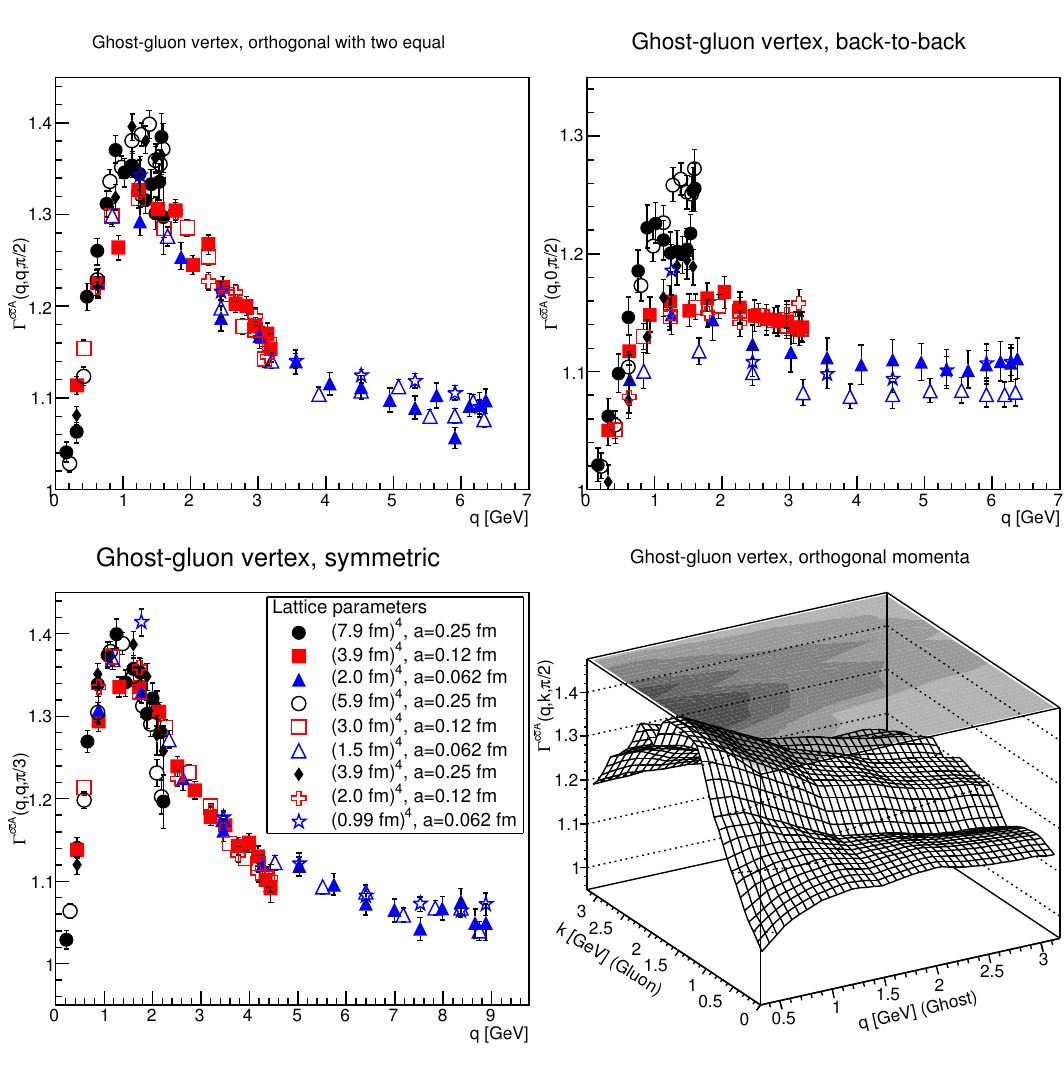
Figure 6: The ghost-gluon vertex in four dimensions. The top-left panel shows a cut along the diagonal of the lower-right plot. The latter shows the situation with the gluon momentum being orthogonal to the ghost momentum, with interpolation of the data points for the largest volume at the intermediate discretization. The top- right panel shows the back-to-back momentum configuration and the bottom-left panel the symmetric momentum